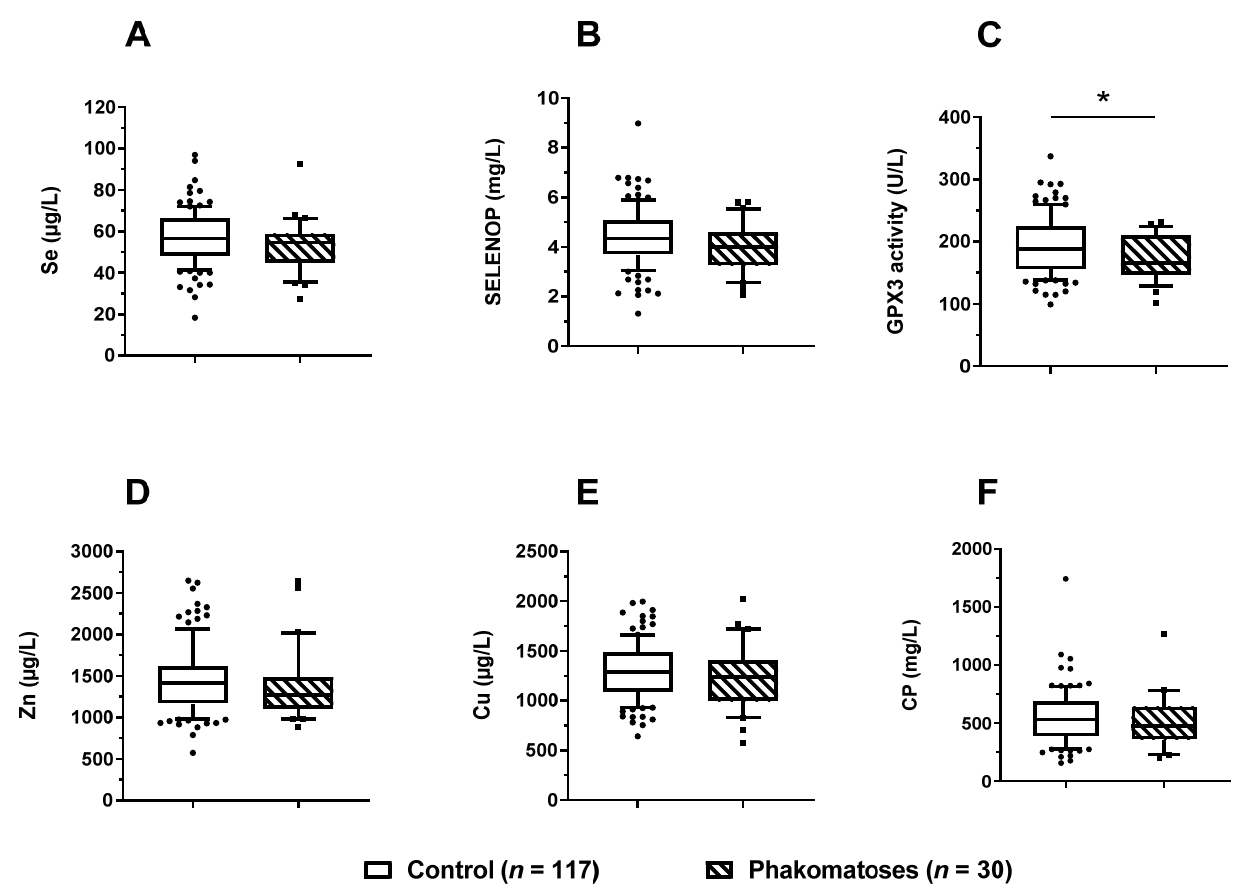
Figure 5. Serum TE status of paediatric patients in relation to phacomatoses. The cohort of paediatric patients was separated according to a diagnosis of phacomatoses. Patients with phacomatoses ( n = 30) displayed a slightly lower but not significantly different ( A ) serum Se, and ( B ) serum SELENOP concentration, along with significantly lower ( C ) serum GPX3 activities ( p = 0.012), as compared with the patients without phacomatoses ( n = 117). No differences between the groups with or without phacomatoses were observed in relation to ( D ) serum Zn, ( E ) Cu, or ( F ) CP concentrations. Data are presented as box plots (10th–90th centiles); general linear model with univariate test adjusted for age was used. p -values < 0.05 were considered statistically significant; * indicates p < 0.05.